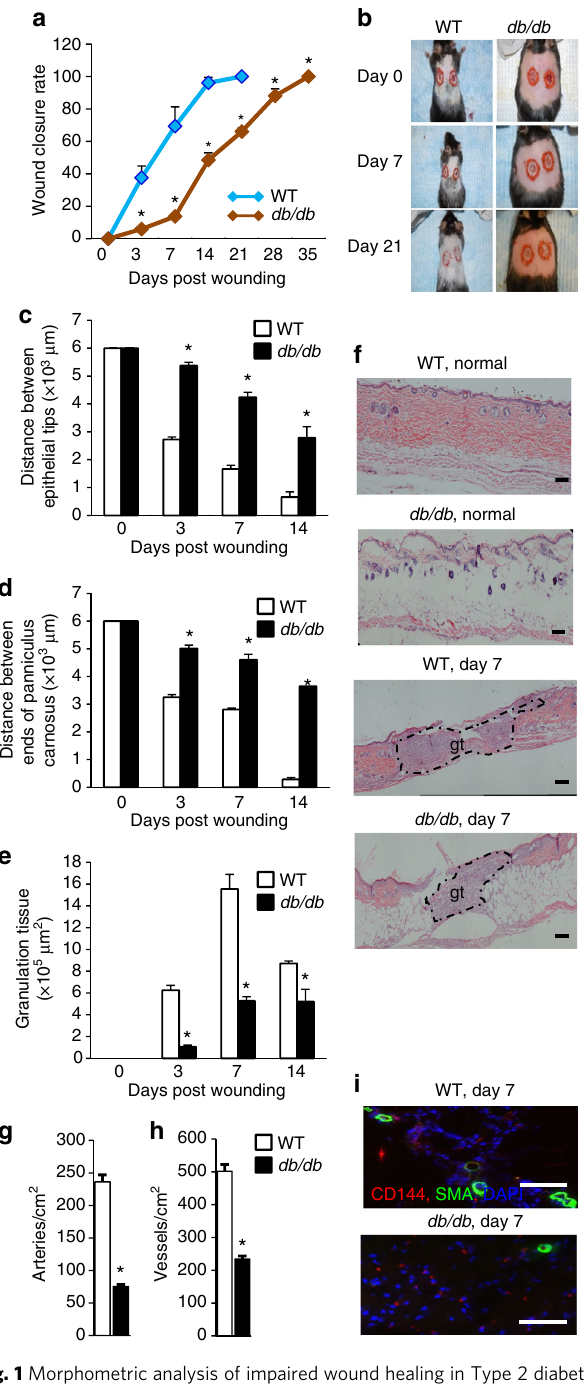
Fig. 1 Morphometric analysis of impaired wound healing in Type 2 diabetic mice. a Wound closure rate measurement ( n = 8, * p < 0.05 vs. WT). b Representative wound images. c – e Histological quanti fi cation of distance between epithelial tips/ends of panniculus carnosus and granulation tissue ( n = 4, * p < 0.05 vs. WT). f Representative H&E staining wound images, magni fi cation ×40. Scale bar, 100 μ m. gt, granulation tissue. g , h Immunohistochemical (IHC) quanti fi cation of vascularization by CD144 and α -SMA staining. i Representative IHC staining images, magni fi cation ×200. Scale bar, 100 μ m. Results are expressed as means ± SEM. Two-tailed unpaired Student ’ s t test was used for a , c – e ,